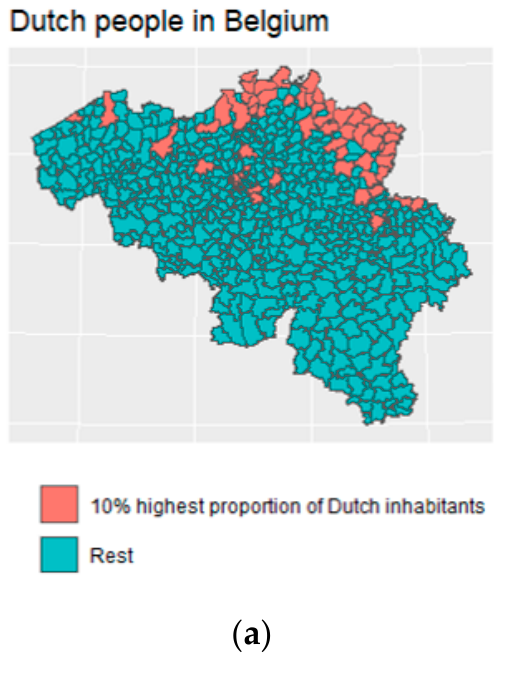
Figure 3. Municipalities with the 10% highest proportion of inhabitants with ( a ) Dutch nationality and ( b ) French nationality.